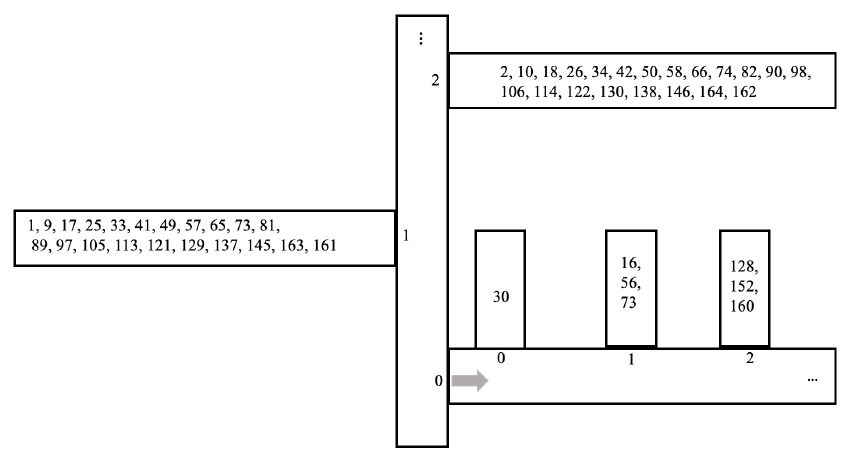
Figure 9. A two − dimensional frequency analysis of toy example output (cid:126) Z component